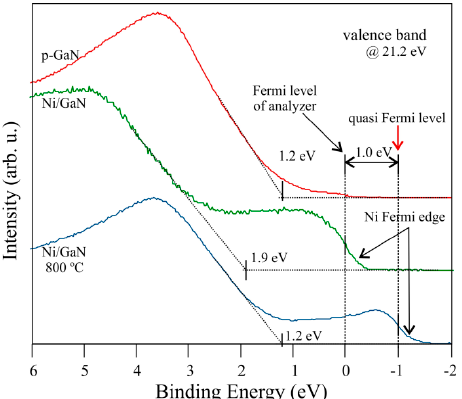
Figure 25. UPS spectra of the valence band for bare and Ni thin ‐ film covered p ‐ GaN(0001) surfaces before and after annealing. Mean film thickness is 1 nm. Reprinted with permission from [30]. Copyright 2020 Elsevie.